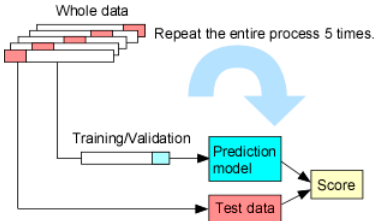
Figure 2. Schematics of 5-fold cross validation where the whole data is split into 5 folds. After the training/validation was completed with the training set (4 folds) in a prediction model, the test set is used to determine the accuracy of the trained model. The entire process is repeated 5 times with each split.